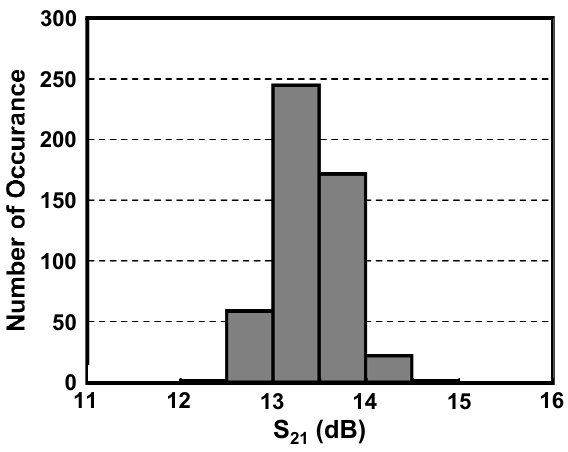
Figure 9. The simulated S 21 at 81 GHz due to neutralization capacitor variations from the Monte Carlo simulation with 500 random runs.